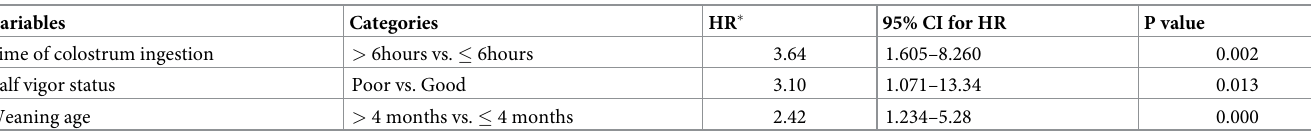
Table 9. Potential risk factors significantly associated with the incidence of crude mortality based on multivariable analysis using Cox regression.